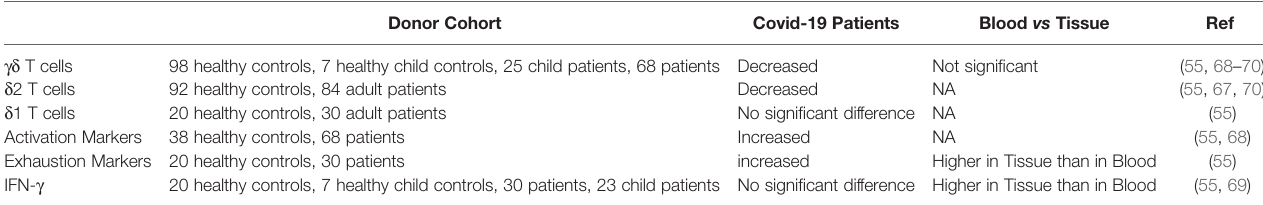
TABLE 1 | Studies reporting on the effects of Covid-19 on gd T cells and related